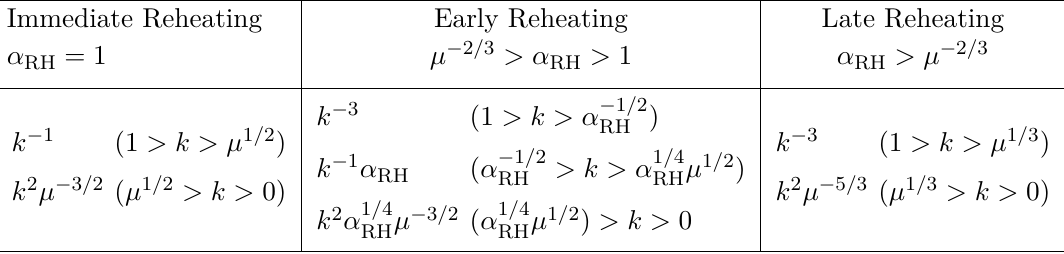
Table 4 . Results for 4 π 2 n k for immediate, early, and late